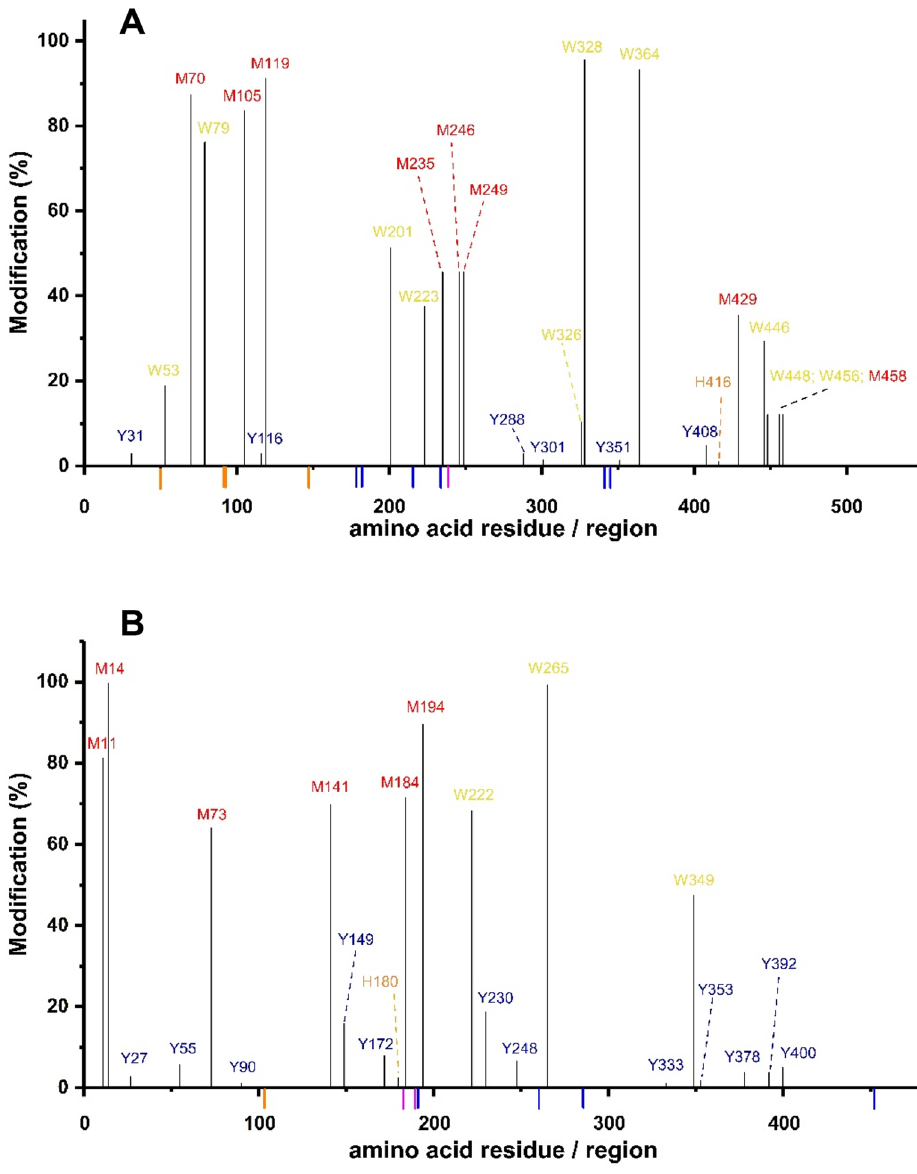
Figure 7. G6PDH and 6PGDH oxidation results in selective damage to amino acids within the protein sequence. G6PDH and 6PGDH (54 μM and 58 μM monomer, respectively) were incubated in the absence or presence of AAPH (10 or 100 mM, 37 °C, 180 min). Panels ( A ) and ( B ) map the oxidative changes detected at individual amino acids by LC–MS in G6PDH and 6PGDH, respectively, after incubation with 100 mM AAPH. The vertical axis indicates the % modification of the residues (Trp, Met, Tyr and His) present at specific sites, calculated as outlined in the Materials and methods from three different replicates, with the horizontal axis indicating the amino acid sequence and numbering. The positions of the binding sites for the substrate and NADP + are indicated on the horizontal axis, in blue and orange, respectively. The residues that act as the proton acceptor (His239, H239) in G6PDH, and the proton acceptor (Lys183, K183) and proton donor (Glu190, E190) in 6PGDH, are indicated in